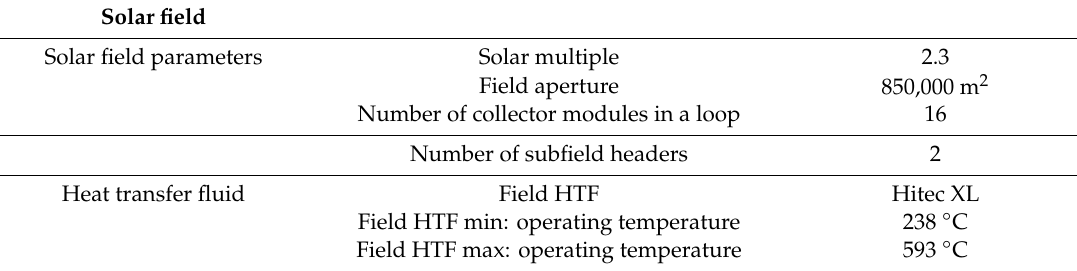
Table 10. Design characteristics and specifications of the 50 MWe LFR